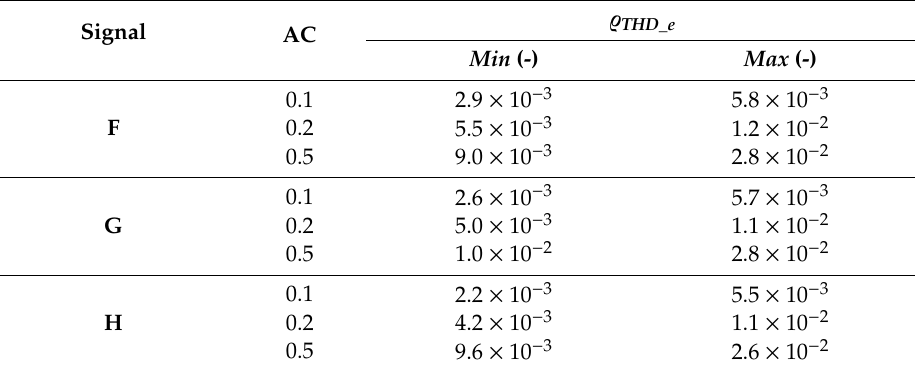
Table 11. Min and max values of 𝝔 𝑻𝑯𝑫_𝒆 for the three signals and all accuracy classes.